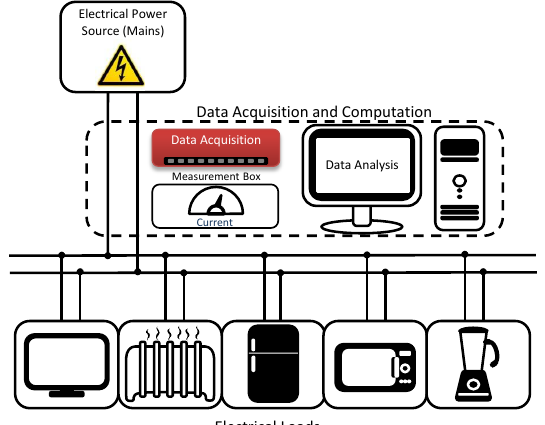
Figure 1. Core components of an appliance load monitoring